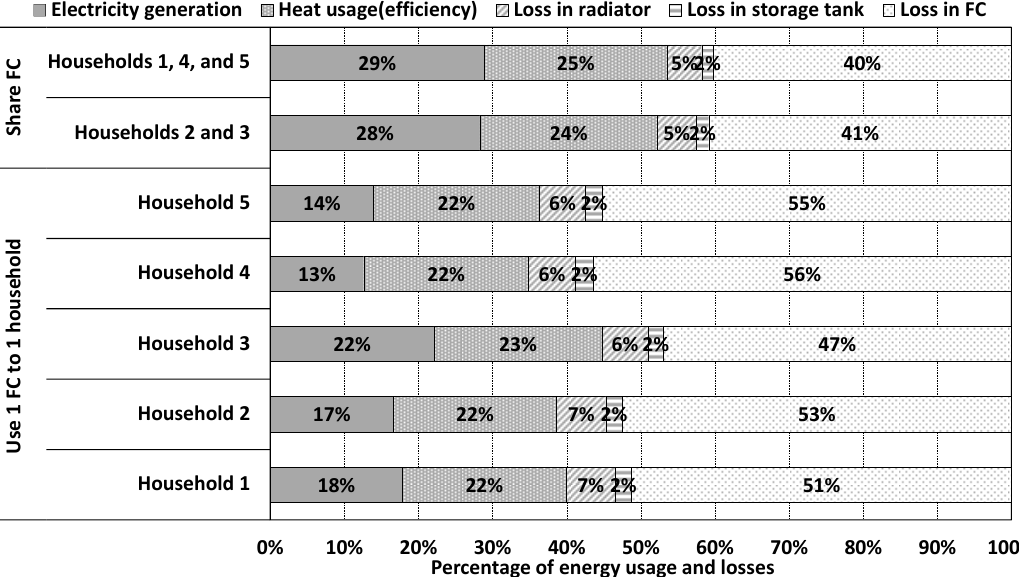
Figure 14. Yearly energy losses of simulating using one SOFC–CGS to one household and multi- households.